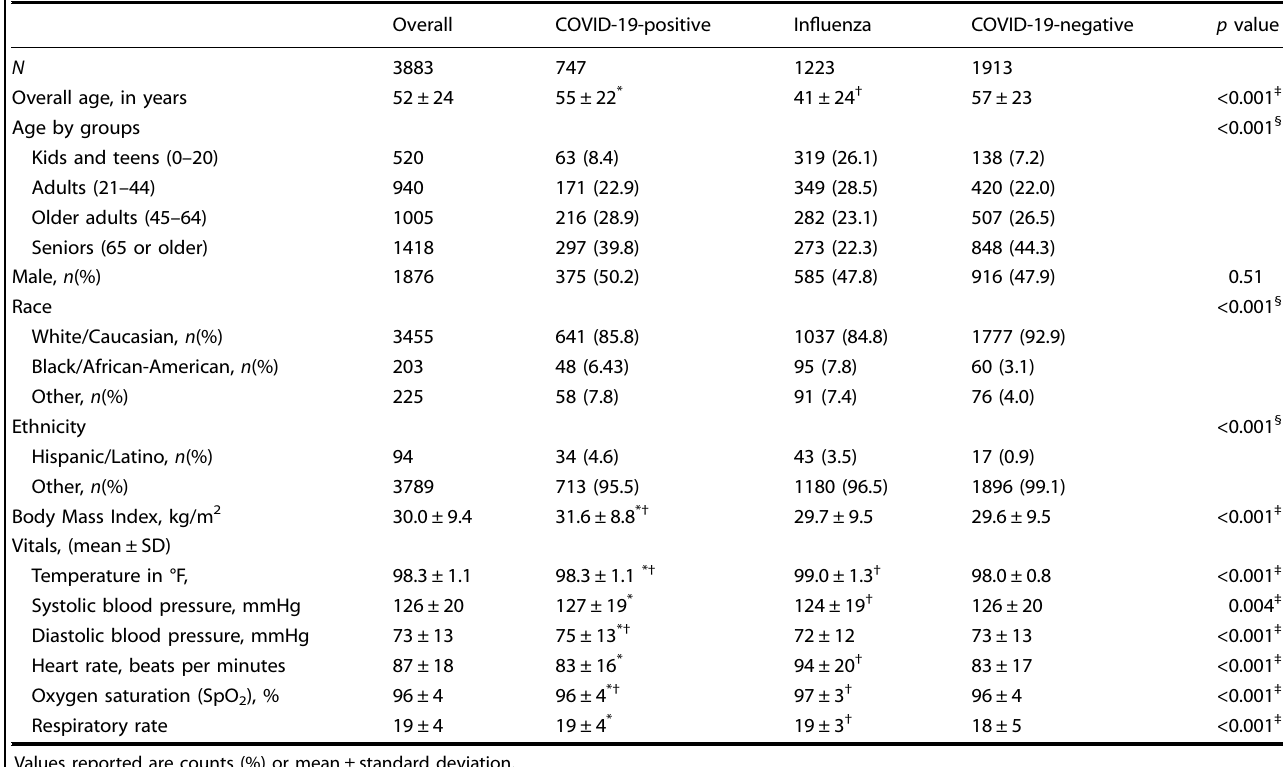
Table 1. Demographics of WVU patients (included COVID-19-positive, COVID-19-negative, and in fl uenza cohort).